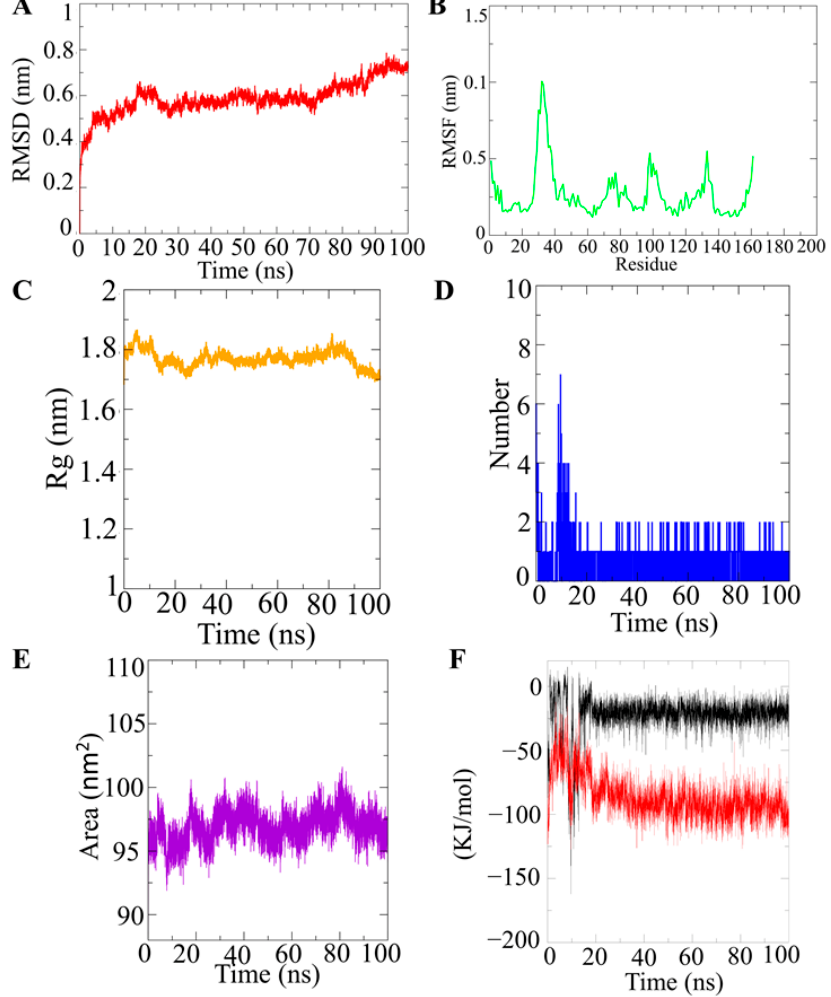
Figure 4. MD simulation analysis of the VanZ–G3K ligand. ( A ): RMSD plot of the VanZ system in complex with G3K. ( B ): RMSF plot of the VanZ system in complex with G3K. ( C ): Rg plot of the VanZ system in complex with G3K. ( D ): Hydrogen bond dynamics between VanZ and the G3K ligand. ( E ): SASA plot for the VanZ system in complex with G3K. ( F ): Coul-SR and LJ-SR interaction energy plot for the VanZ system in complex with G3K. MD simulation was repeated three times.